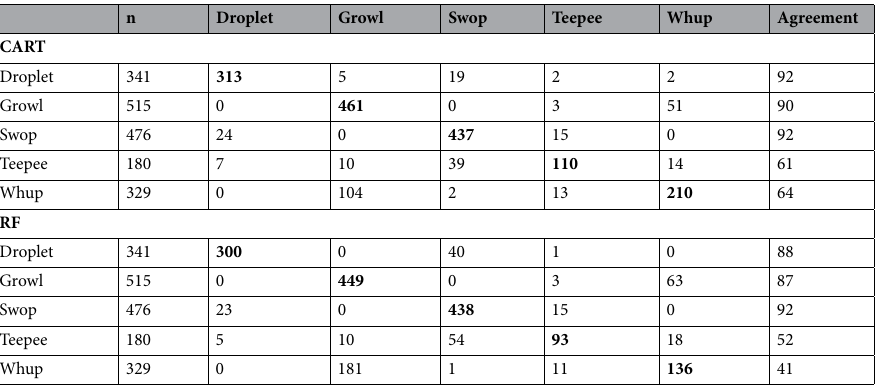
Table 3. CART and RF confusion matrices with sample size (n) for each call type, showing the number of cases correctly assigned to each observer classified call type in bold along the diagonal. Percent classification success in the CART and RF is given for each call type in the last column. The CART had an overall classification success of 83% (n = 1531/1841) and the RF 77% (n = 1416/1841). In the RF, the most important variables based on the Gini index were end, trend, dur, start, and upper. Variable abbreviations correspond to those in Table